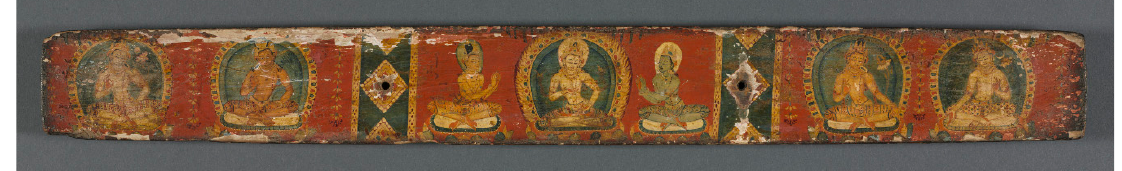
Figure 13. Four bodhisattvas and two attendants flanking Vajrasattva, bottom cover. Perfection of Wisdom in Eight Thousand Lines: A ṣṭ as ā hasrik ā Prajñ ā p ā ramit ā -s ū tra , 1119. Nepal. Gum tempera on wood. Overall: 6.5 × 57 × 1.5 cm. Cleveland Museum of Art, purchase from the J. H. Wade Fund, 1938.301.7.